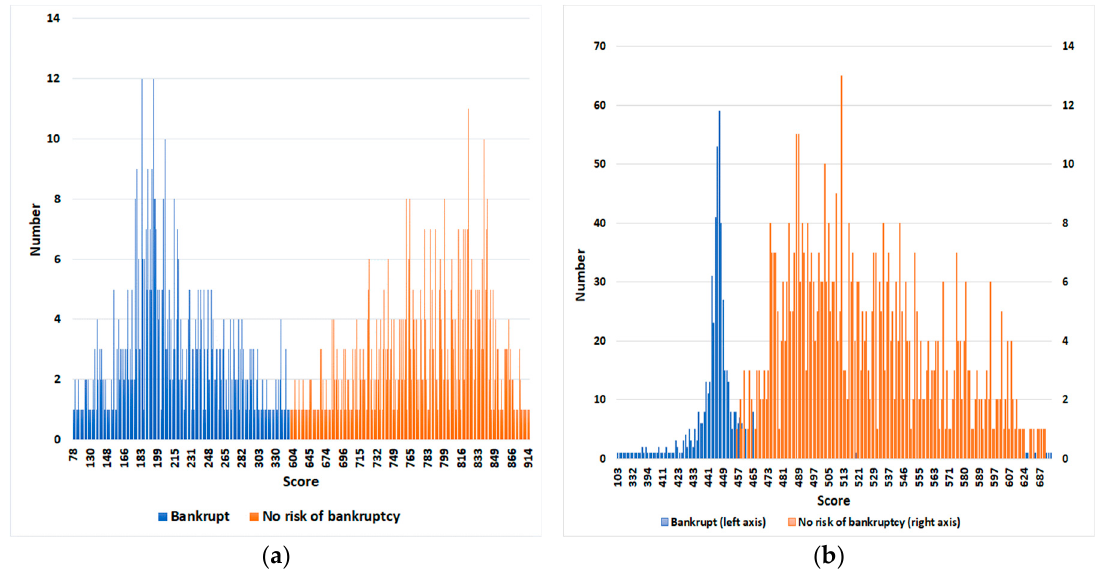
Figure 12. Score distribution for healthy and bankrupt businesses: ( a ) for the GBM model and very high divergence of distributions Div = 92.1; ( b ) for the LDA model and low divergence of distributions Div = 2.6. Source: own elaboration using Excel.